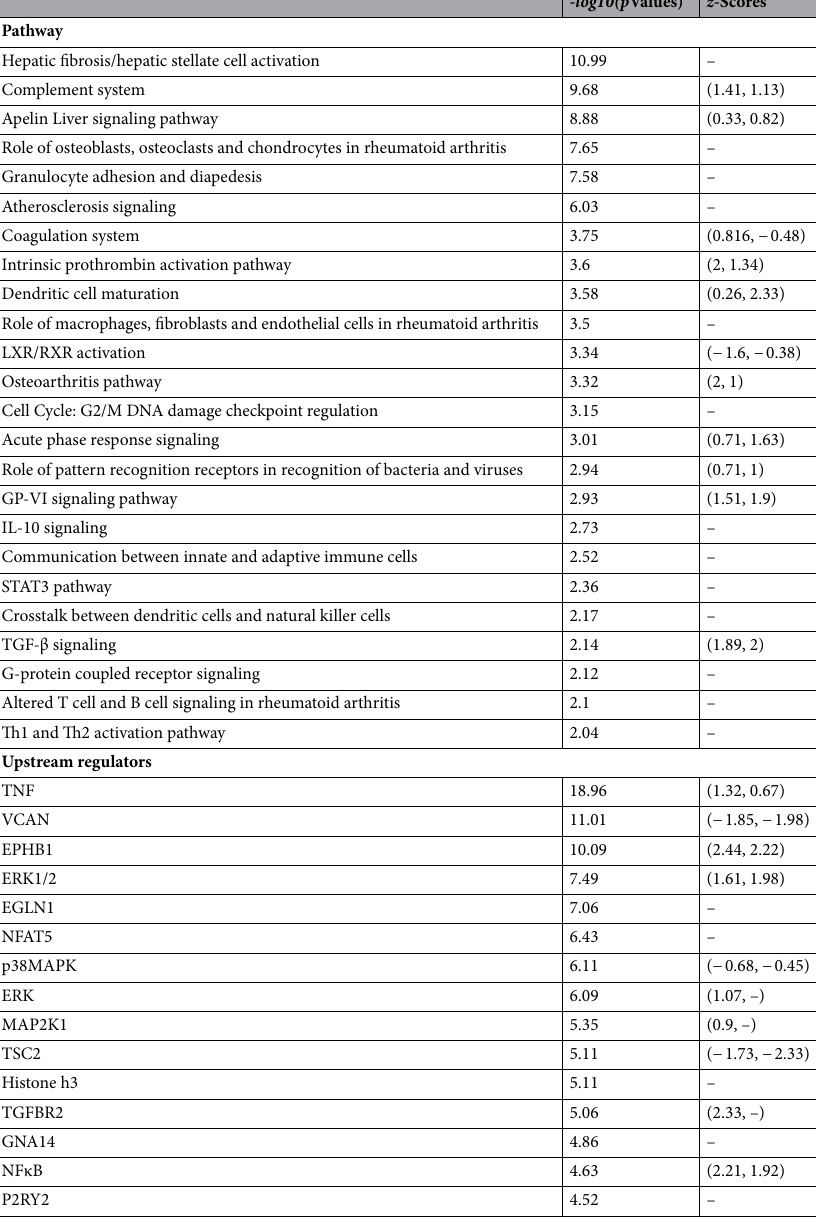
Table 1. Top ranked pathways and upstream regulators by Ingenuity Pathway Analysis in lungs from a SuHxNx rat model of severe